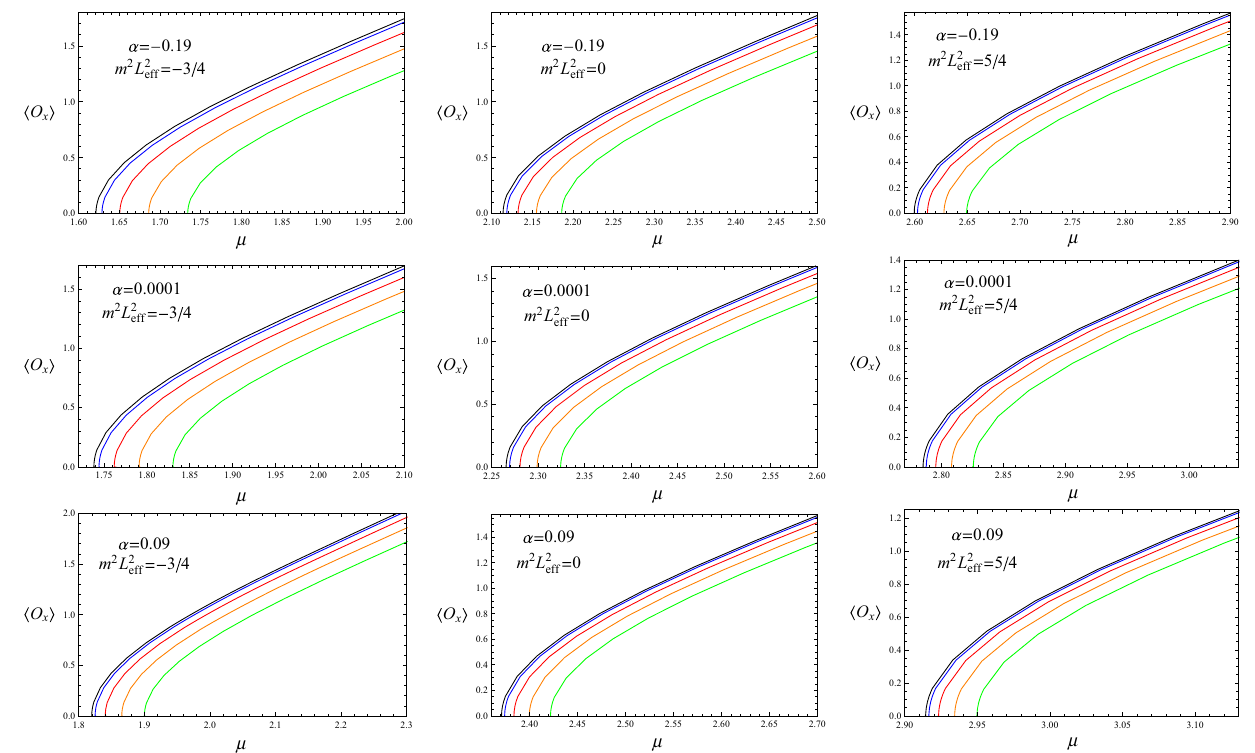
Fig. 1 The condensate as a function of the chemical potential for dif- ferent values of Gauss–Bonnet parameter α with the fixed mass of the = − 3 / 4 , 0 , 5 / 4, respectively in the holographic vector field m 2 L 2 ef f p-wave superfluid model in AdS soliton. In each panel the five lines